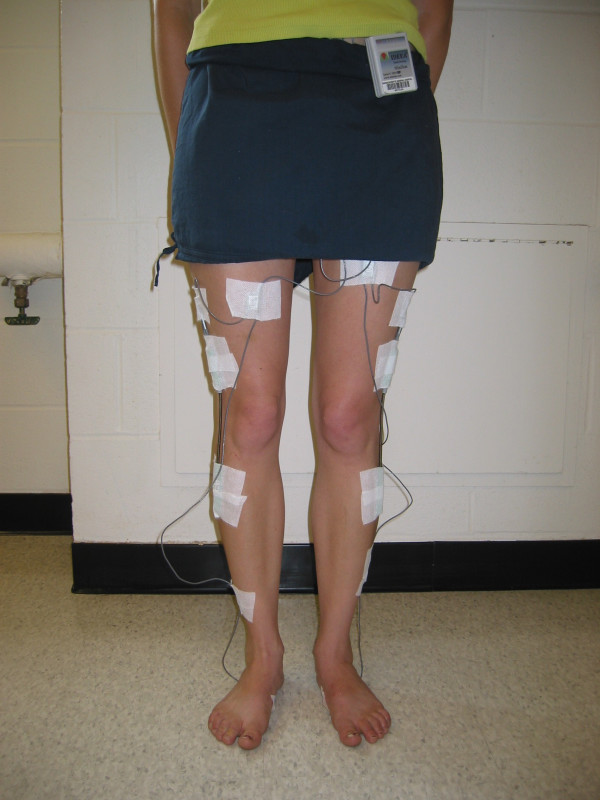
Photograph (front view) of the modified IDEEA system being worn by a patient.